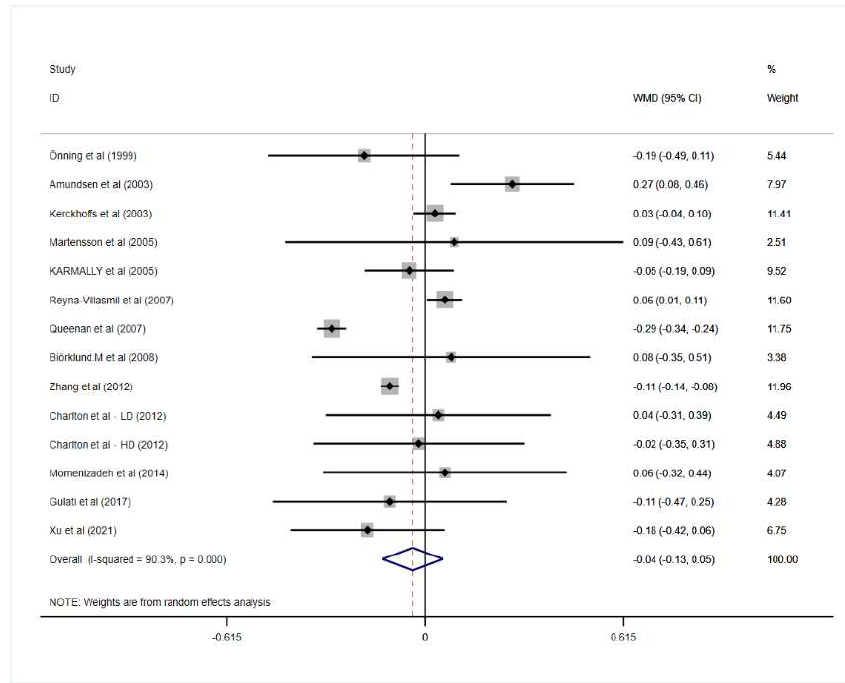
Figure 3. Effect of oat β-glucan on total triglyceride (mmol/L) in patients with hyperlipidemia. Open diamonds: synthesis of summary results of all studies; Filled diamonds: point estimates for effect of each study; Dashed lines: summary effect estimate which is labeled as a dashed line perpendicular to the X axis; Grey squares: the weight of each study, the value of weigh is proportional to the diamond size; WMD: weighted mean difference.